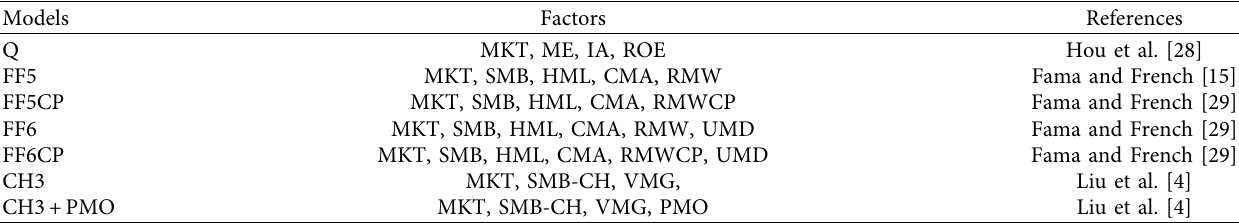
Table 1: Models and factors.